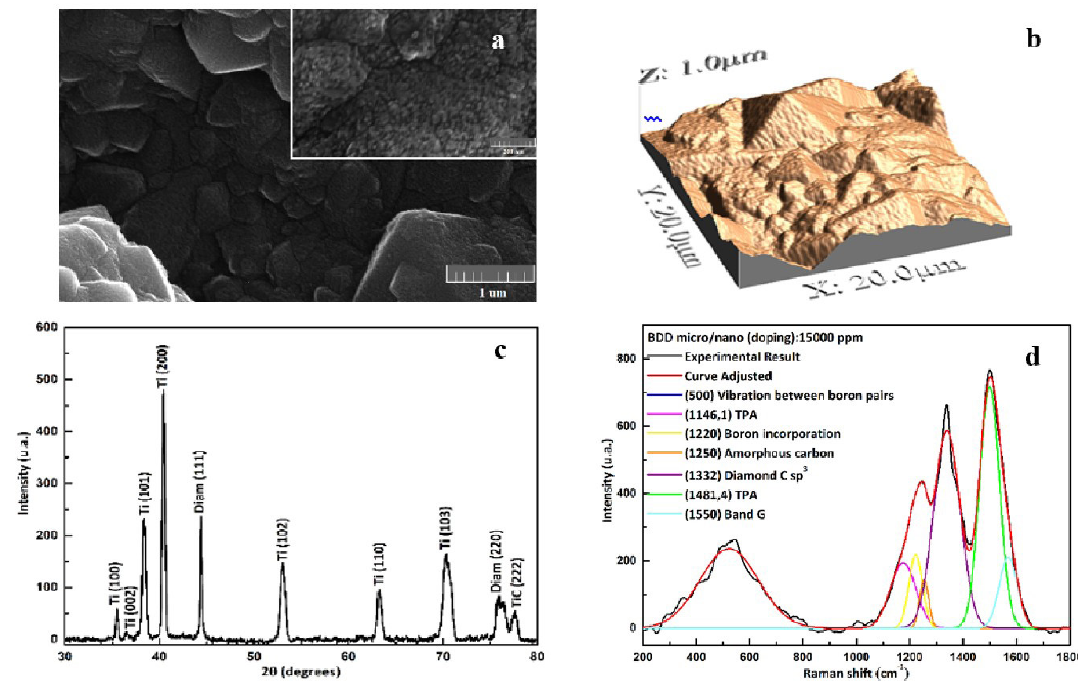
Figure 1. Morphological analysis images and graphs of the structural analysis of the BDD micro/nano electrode grown on titanium substrate with the doping level of 15000 ppm. (a) SEM; (b) AFM; (c) XRD; (d)